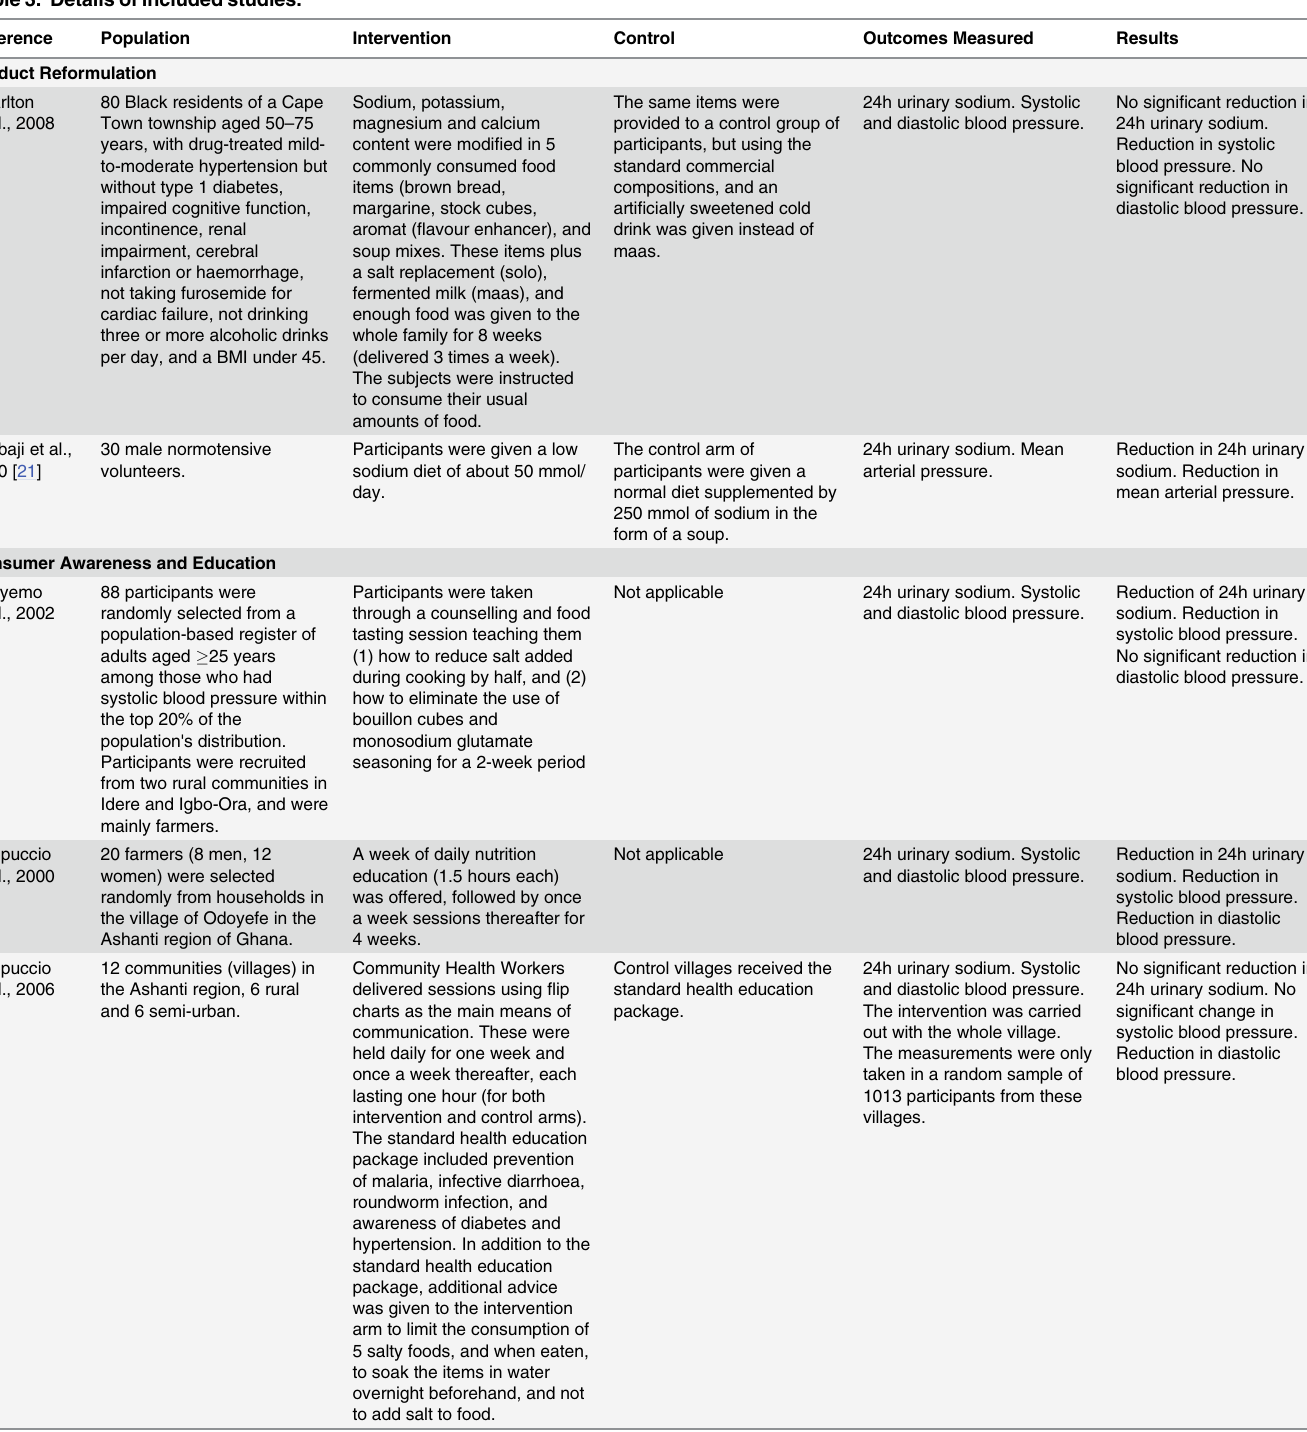
Table 3. Details of included